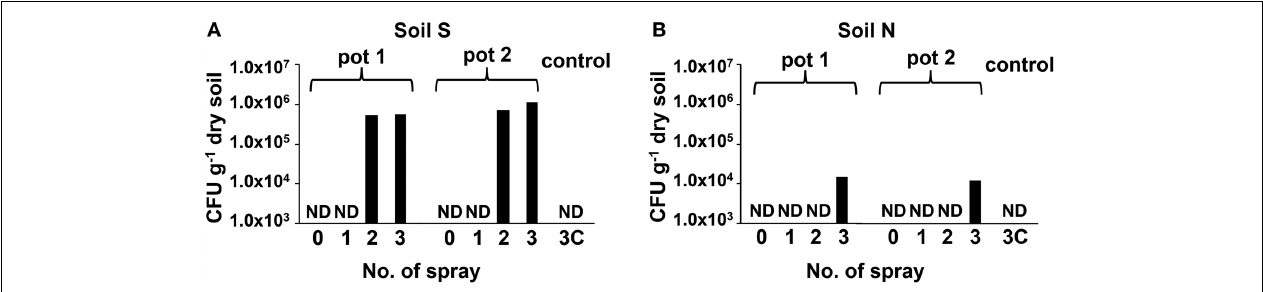
FIGURE 1 | Transition of CFU of MEP-degrading bacteria in MEP-sprayed soils. CFU of MEP-degrading bacteria in soil S (A) and soil N (B) were counted by using MEP medium plates. Results of replicated experiments (pot 1 and pot 2) are shown. ND, not detected ( < 1 . 0 × 10 3 cfu g − 1 -dry soil).